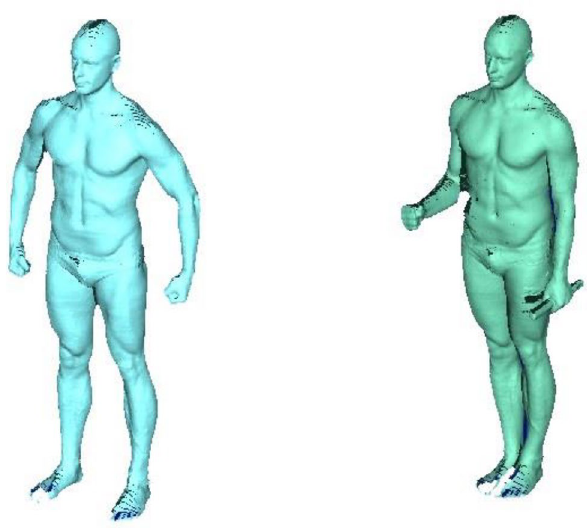
Figure 2. Typical standing upright positions with fixed points based on manufacturer’s instructions. Typical standing upright position without (left image) and with wooden dipstick (right image). On right image the left hand holds a small wooden stick (“dipstick”) vertically. The images were provided with kind permission of the